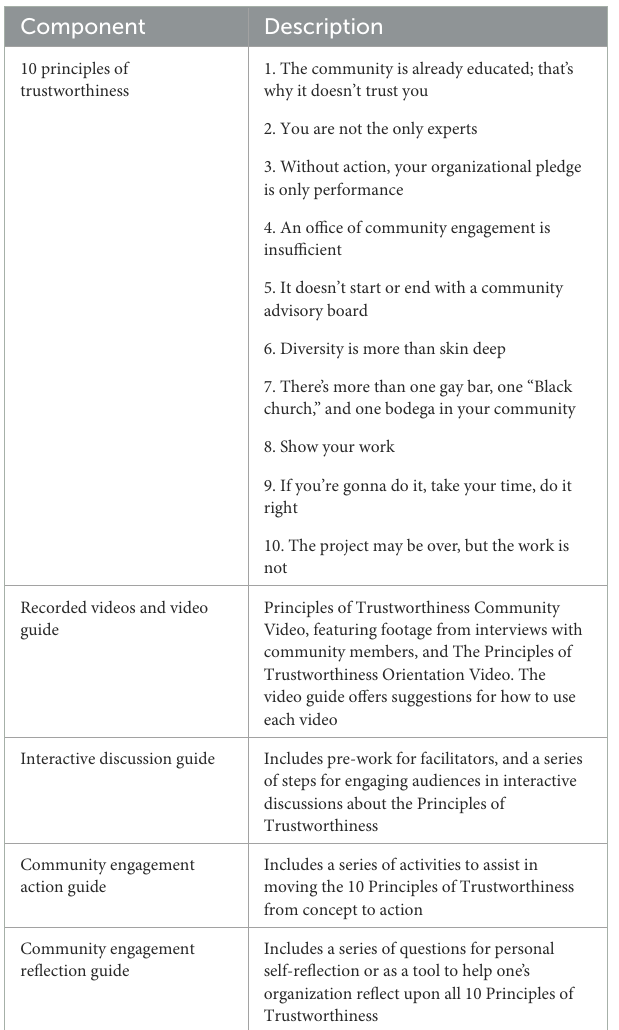
TABLE 2 Description of principles of trustworthiness toolkit